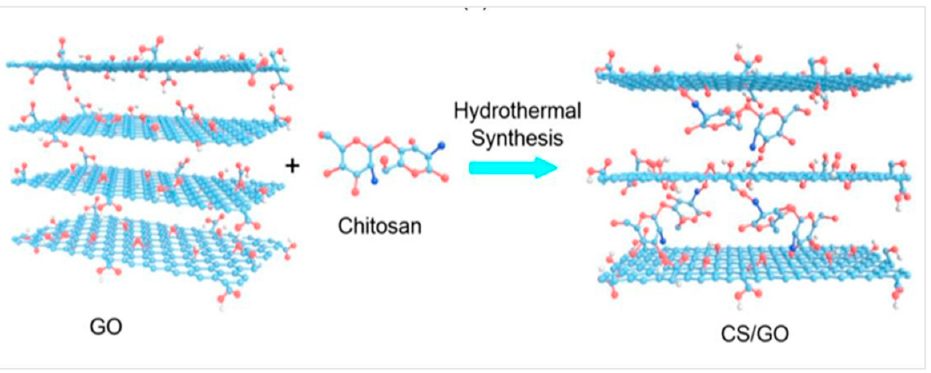
Figure 4. Schematic mechanism of graphene oxide with chitosan aerogel via hydrothermal method [63].